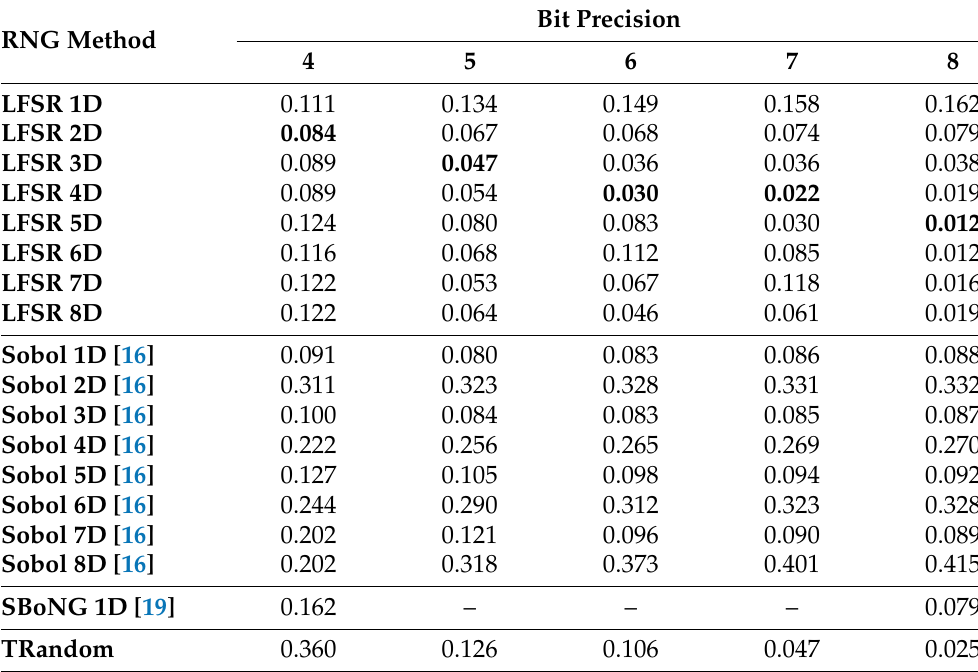
Table 3. MAE comparison for the bipolar SQF using different RNGs. The best result for each column is highlighted in